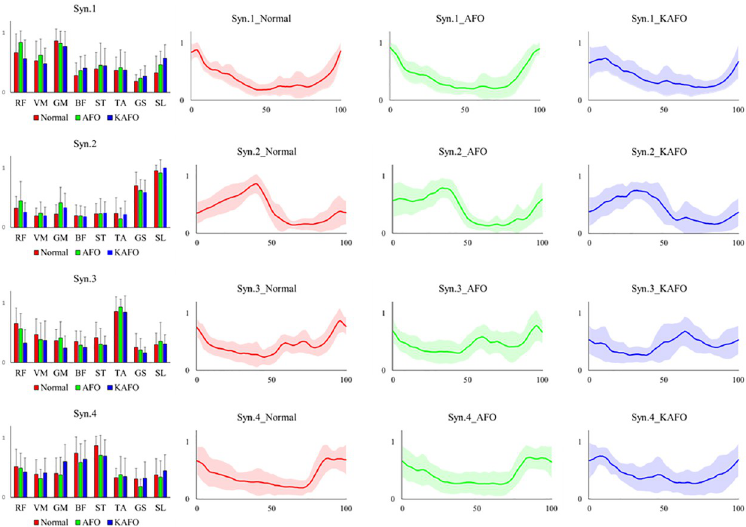
Fig 4. The characteristics of muscle synergy. The left figures represent the activation pattern of muscle synergies, and the right figures demonstrate the weighting of muscles involved in each synergy among the three conditions (Normal/